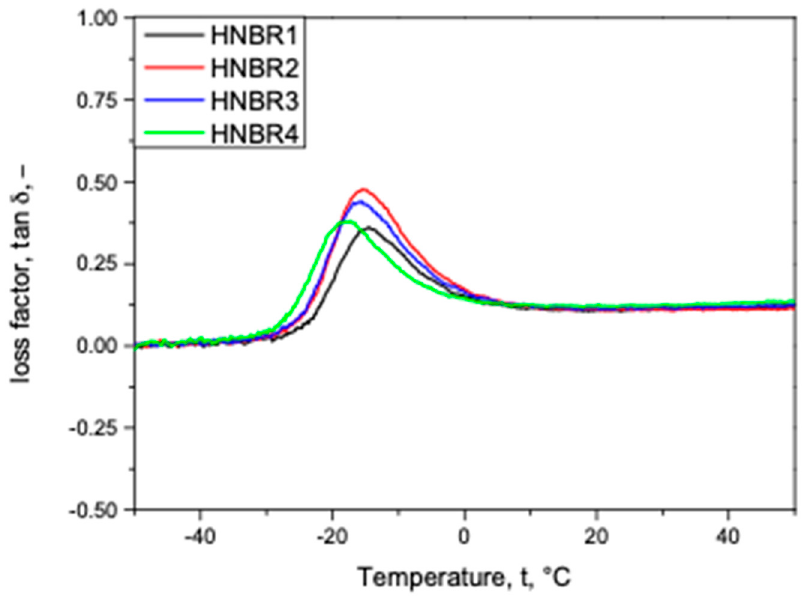
Figure 3. The temperature dependence of different CB grade compositions in HNBR on DMA analysis: the loss factor tan δ .